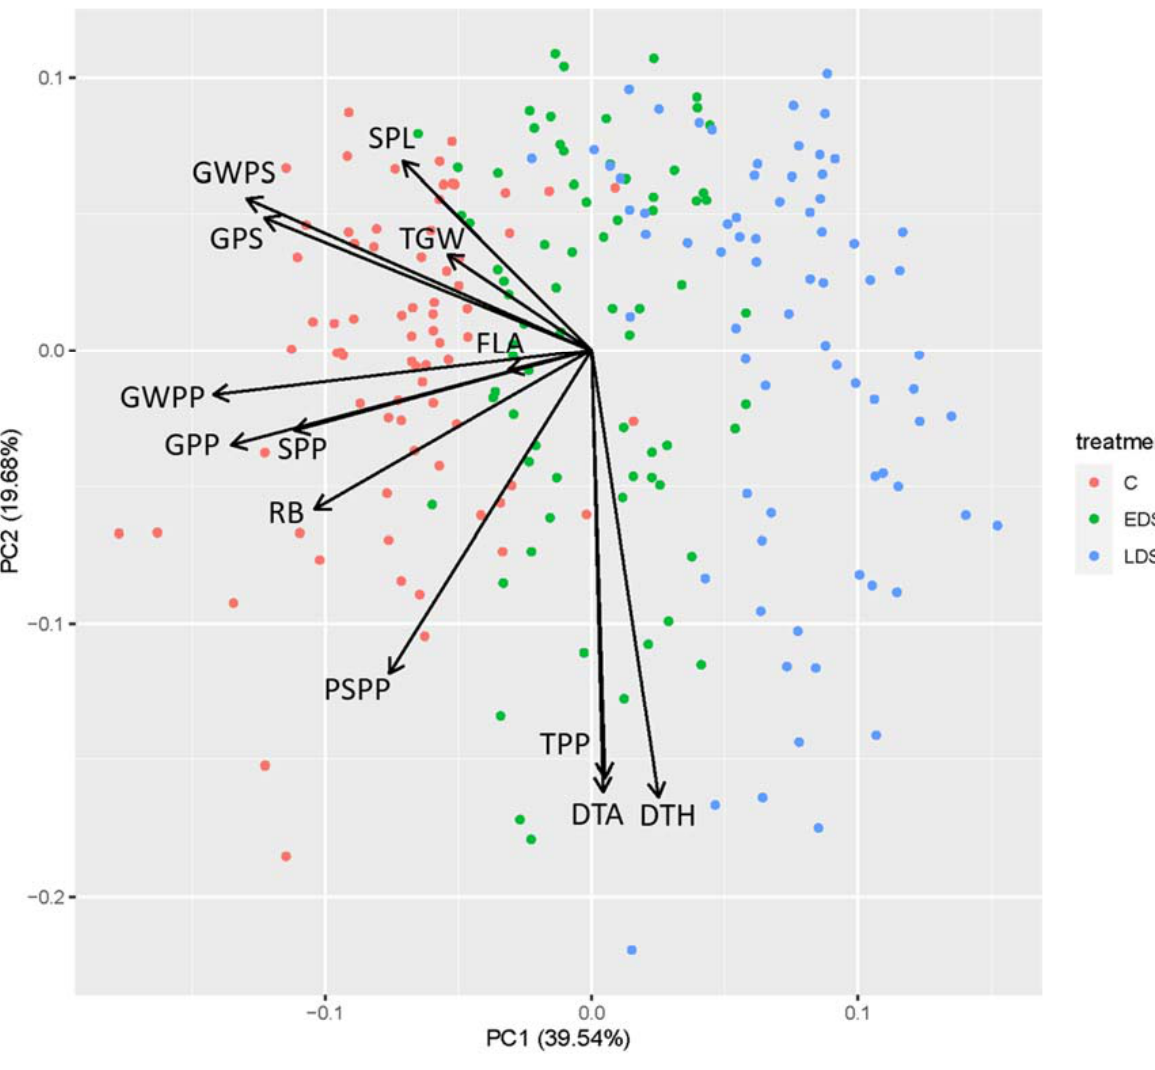
Figure 3. Biplot from principal-component analysis (PCA) for traits, root biomass (RB), days to heading (DTH), days to anthesis (DTA), tillers per plant (TPP), spikes per plant (SPP), productive spikes per plant (PSPP), flag-leaf area (FLA), spike length (SPL), 1000-grain weight (TGW), grains per spike (GPS), grains per plant (GPP), grain weight per spike (GWPS), and grain weight per plant (GWPP) in 73 spring-wheat genotypes under control (C), early drought stress (EDS) and late drought stress (LDS).